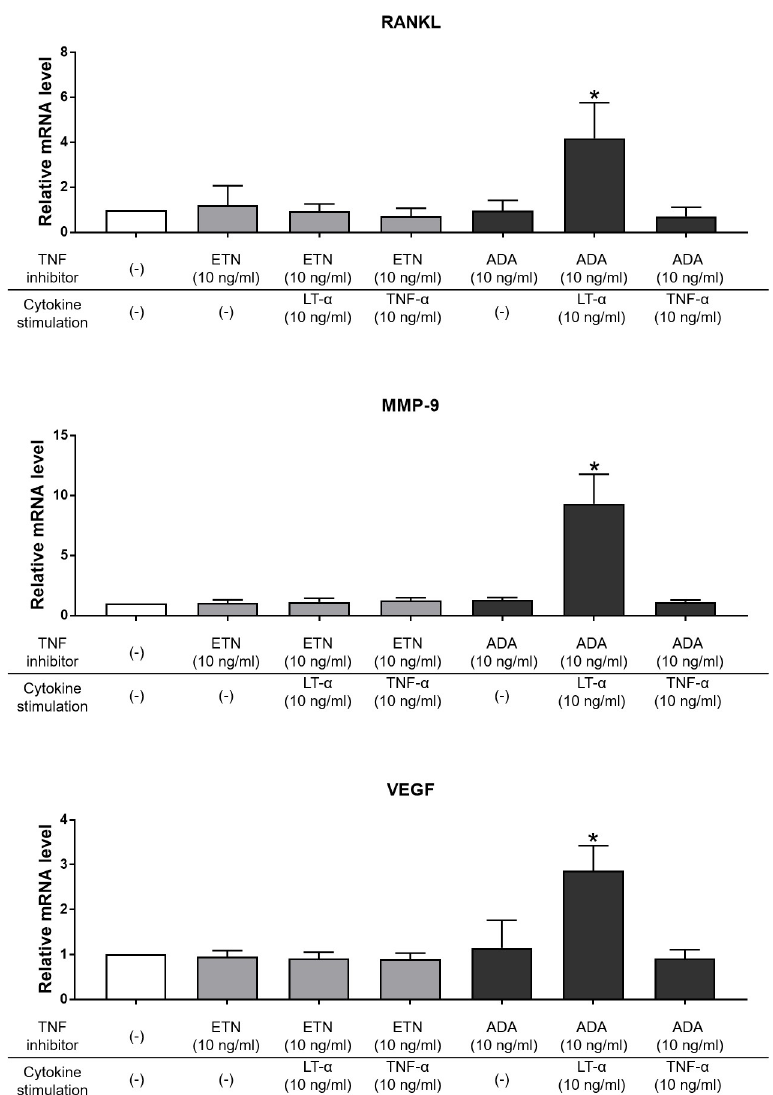
Fig 5. Relative mRNA level of RANKL, MMP–9 and VEGF, preincubated with TNF inhibitor before 24 hours cytokine stimulation. Each value obtained for the control cells (chondrocytes without cytokine stimulation and TNF inhibitor treatment) was set to one. Etanercept inhibited the effects of both LT– α and TNF– α , while adalimumab only inhibited the effects of TNF– α in chondrocytes. LT– α promoted the expression of RANKL, MMP–9 and VEGF independently of TNF– α (n = 6 per experimental group). � p < 0.001. ETN, etanercept; ADA,